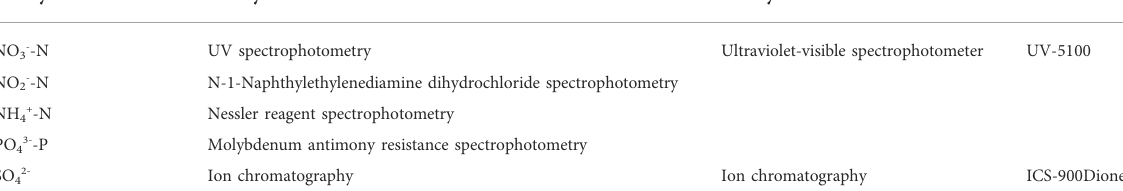
TABLE 1 Water quality analysis methods.